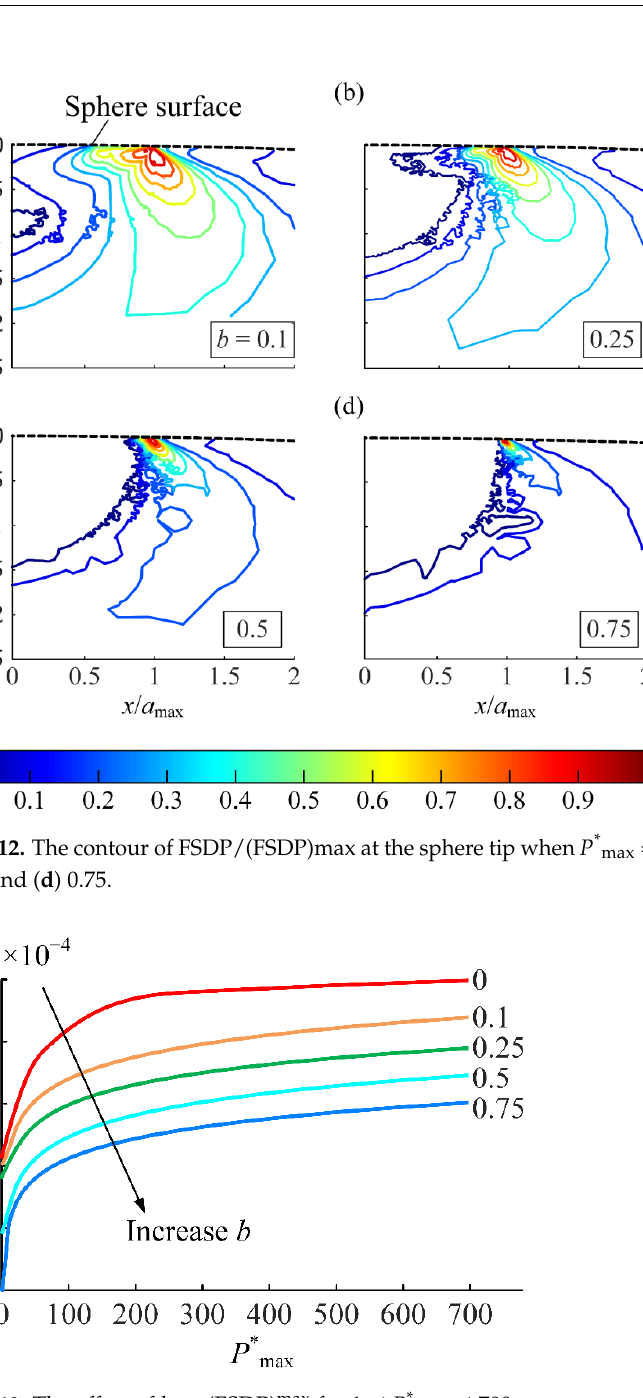
Figure 13. The effect of b on (FSDP) max for 1 ≤ P * max ≤ 700.